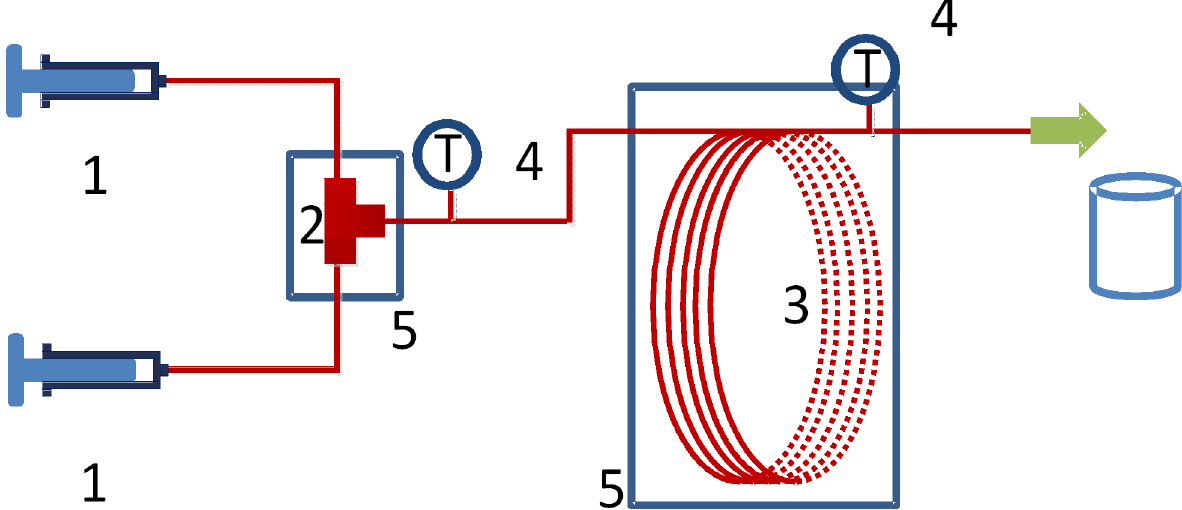
Figure 1: The experimental set-up. (1 - Glass syringe, 2 - T-micromixer, 3 - Microchannel reactor, 4 - Thermocouple, 5- Thermostatic